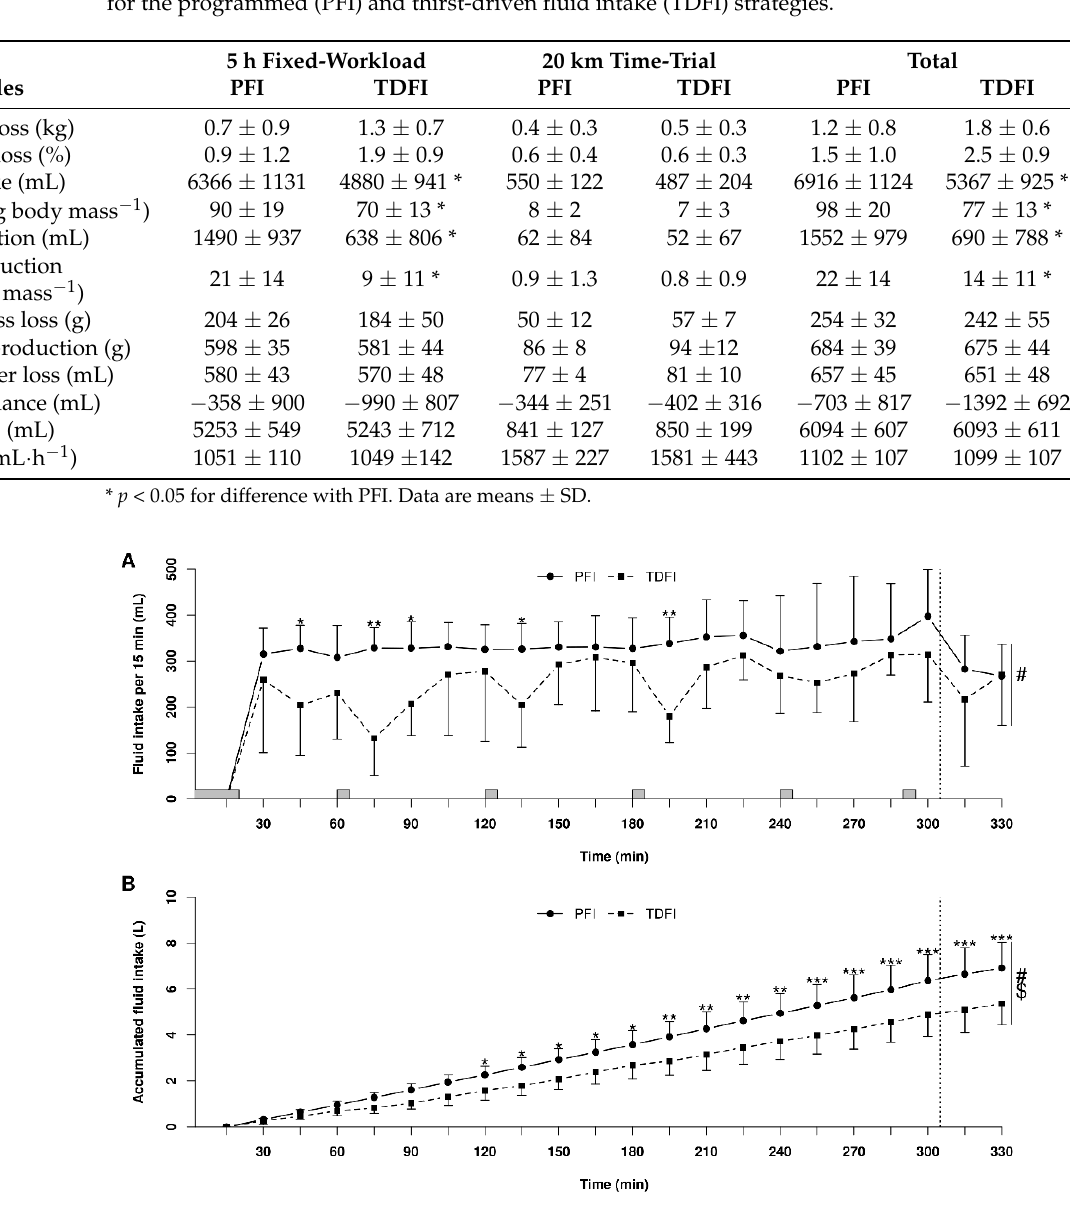
Figure 2. Patterns of fluid intake during the 5 h fixed-workload exercise period and the 20 km time-trial for the programmed (PFI) and thirst-driven fluid intake (TDFI) strategies. Fluid intake per 15 min interval ( A ) and accumulated fluid intake ( B ). * p < 0.05, ** p < 0.01, *** p < 0.001 for difference between conditions, # significant time effect ( p < 0.001), $ significant interactions ( p < 0.05). Vertical dotted line represents the onset of the time-trial. Shaded areas above the x-axis represent the moments when athletes did not have access to water. Values are means ± SD.